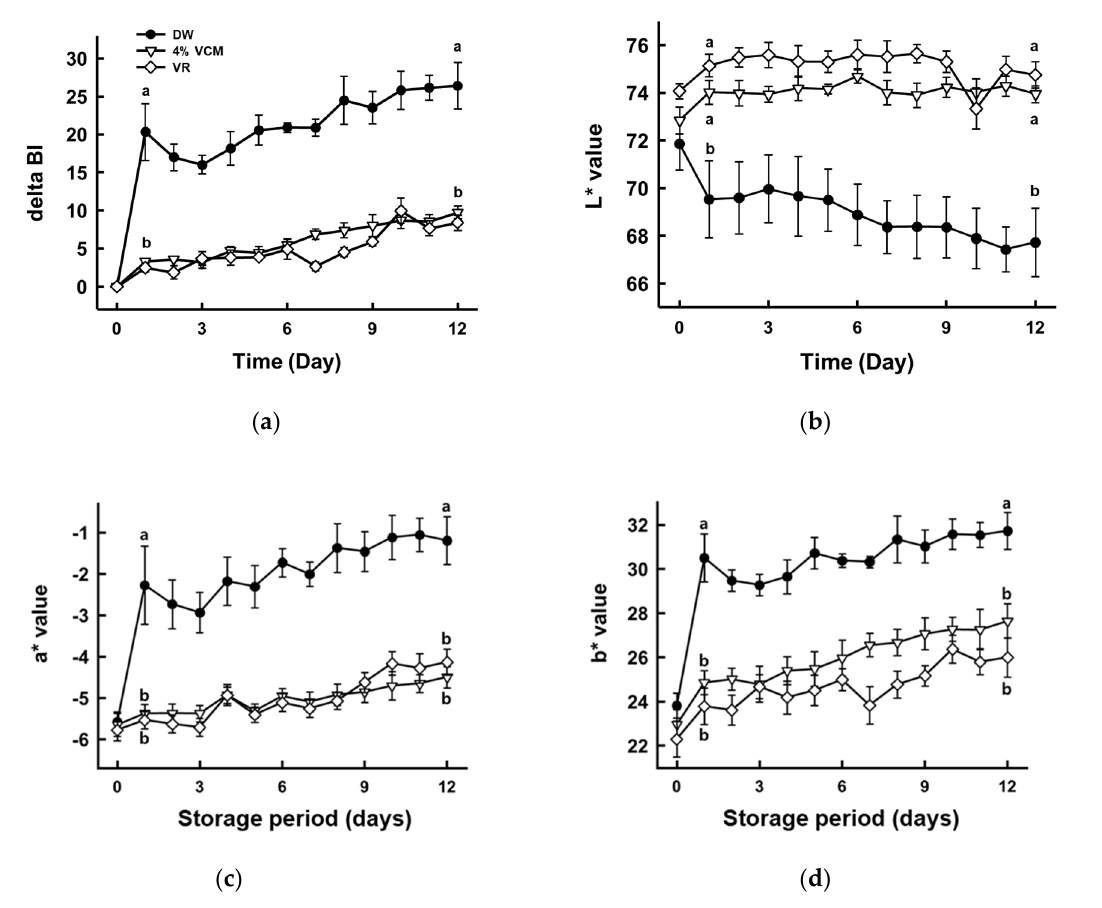
Figure 2. Changes in the color of freshly cut apples due to treatment with an anti-browning reagent. Changes in the color value of the apple cube surface according to various processing solutions for DW, 4% VCM, and VR. ( a ) Delta BI value, ( b ) CIE L* value, ( c ) a* value, and ( d ) b* value. Statistical significance was determined by one-way ANOVA (mean ± SE, n = 4).